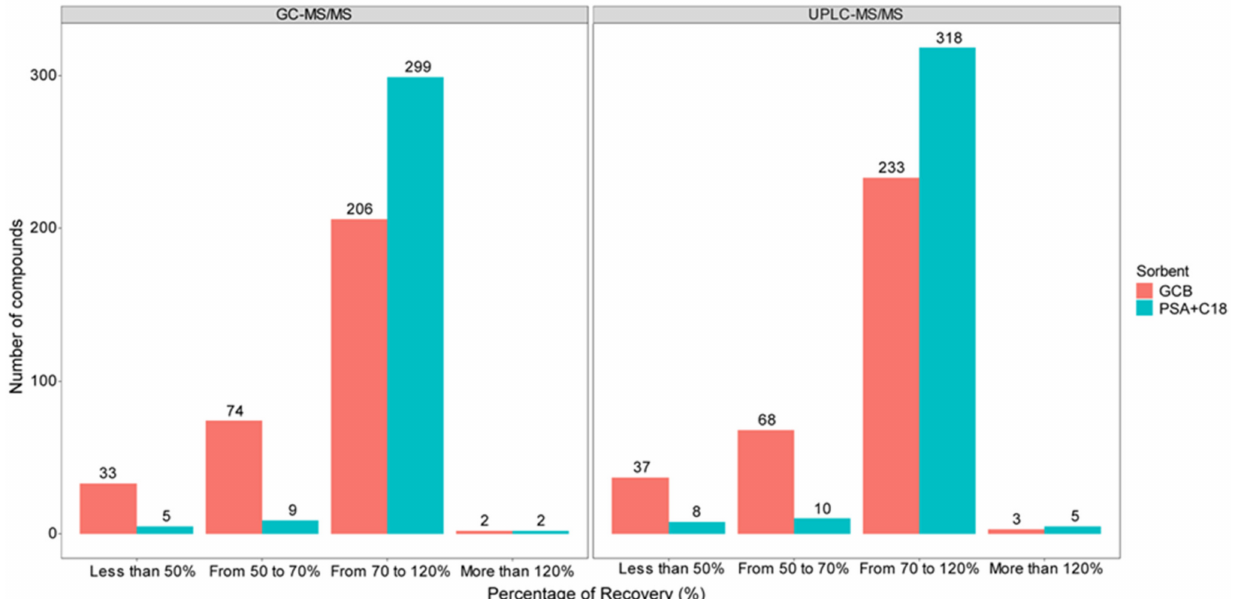
Figure 2. Comparision of the number of compounds obtained at different recoveries by using different SPE sorbents (UPLC-MS/MS: 341 compounds, GC-MS/MS: 315